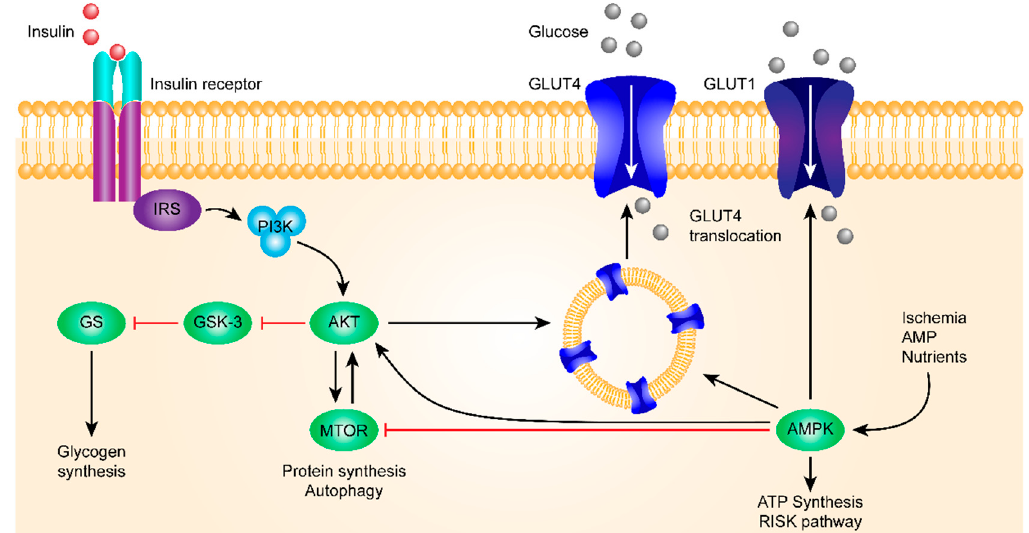
Figure 1. This figure shows the insulin signaling pathway. The insulin receptor binds insulin, has a tyrosine-protein kinase activity, and mediates the metabolic functions of insulin. Binding to insulin stimulates the association of the receptor with downstream mediators, including insulin receptor substrate-1 (IRS-1) and PI3K. The insulin receptor can activate PI3K either directly, by binding to the p85 regulatory subunit, which produces PIP3, or indirectly, which leads to phosphorylation and the activation of AKT. Afterward, AKT phosphorylates the Ser9 site of GSK-3 β and inhibits its activity. The PI3K / AKT / GSK-3 β signaling pathway is involved in the insulin signaling transduction, and GSK-3 β is regulated and controlled by insulin in this signaling pathway, which is related to the glycogen synthesis regulation.